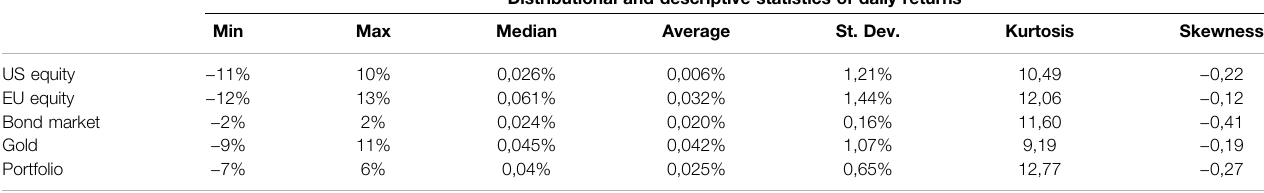
TABLE 2 | Analysis of portfolio and components time series.